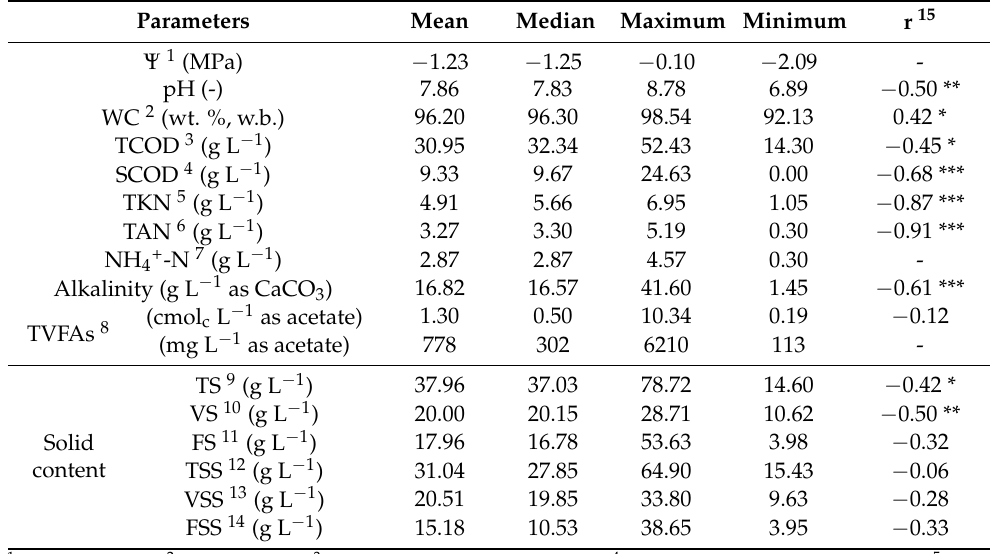
Table 4. Physicochemical properties of anaerobic digestates (n = 20) investigated in this study. Parameters